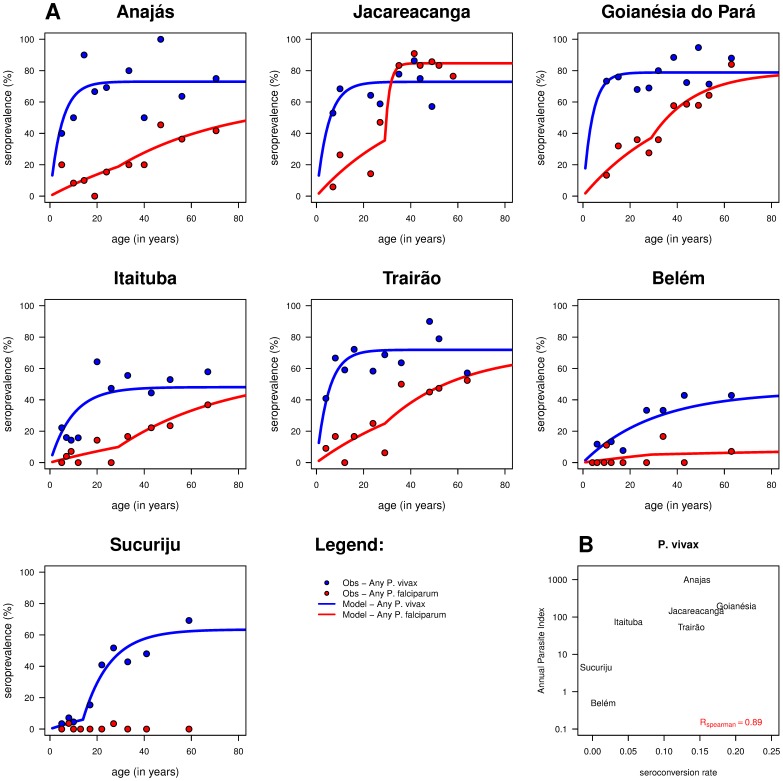
Statistical analysis of seropositivity data.
A. Age-adjusted seroprevalence for any P. vivax (blue solid lines) or P. falciparum antigens (red solid lines) using appropriate reversible catalytic models. The observed seroprevalences for each Plasmodium species (blue- and red-filled circles) were pooled according to the 10%-centiles of the underlying age distribution. Note that Sucuriju data for P. falciparum were excluded from the analysis due to the small number of sero-positive individuals (two cases only). B. Correlation analysis for any P. vivax antigens using the annual parasite index versus seroconversion rate.